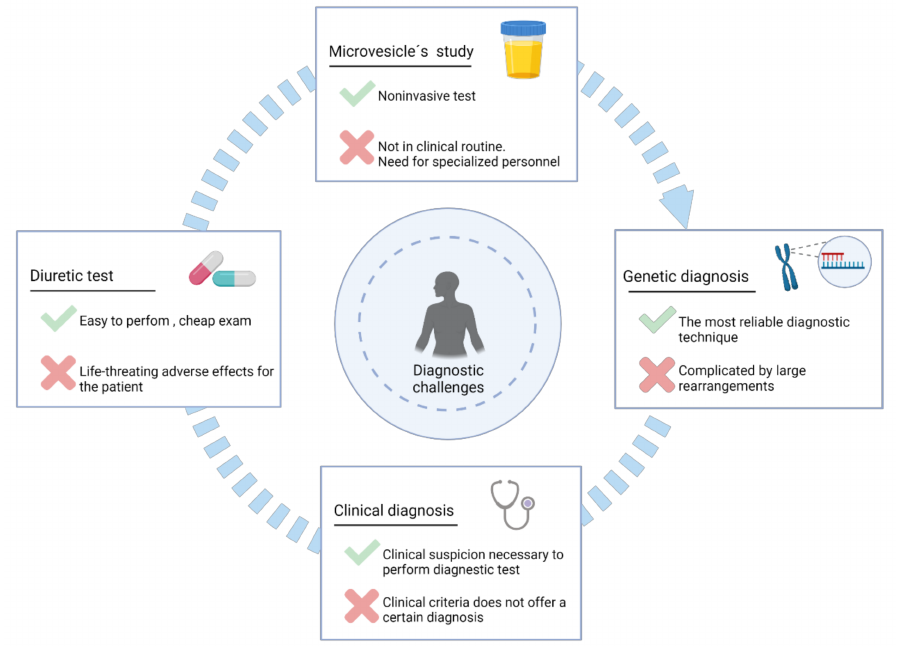
Figure 2. Main methods for the diagnosis of Gitelman and Bartter syndromes. Each method is accompanied by its principal benefit and the major